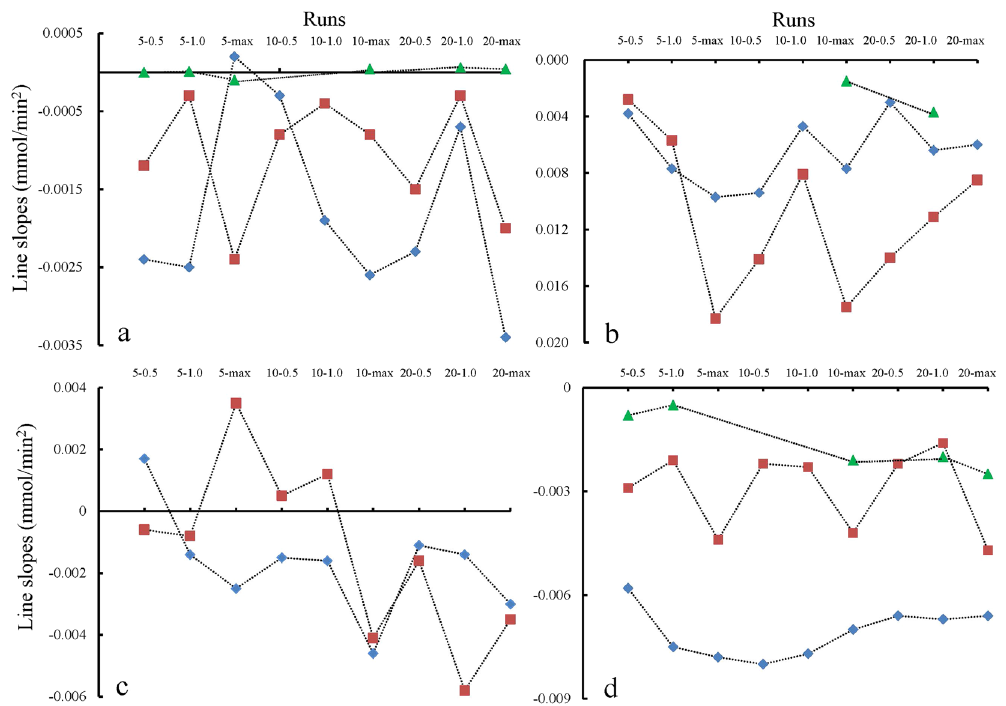
Figure 4. Slopes in the plots of gas flow rates versus time over stages II–V, denoted as a–d respectively. The diamond, square, and triangle markers represent the experiments at 1.45, 6.49, and 12.91 °C, respectively.